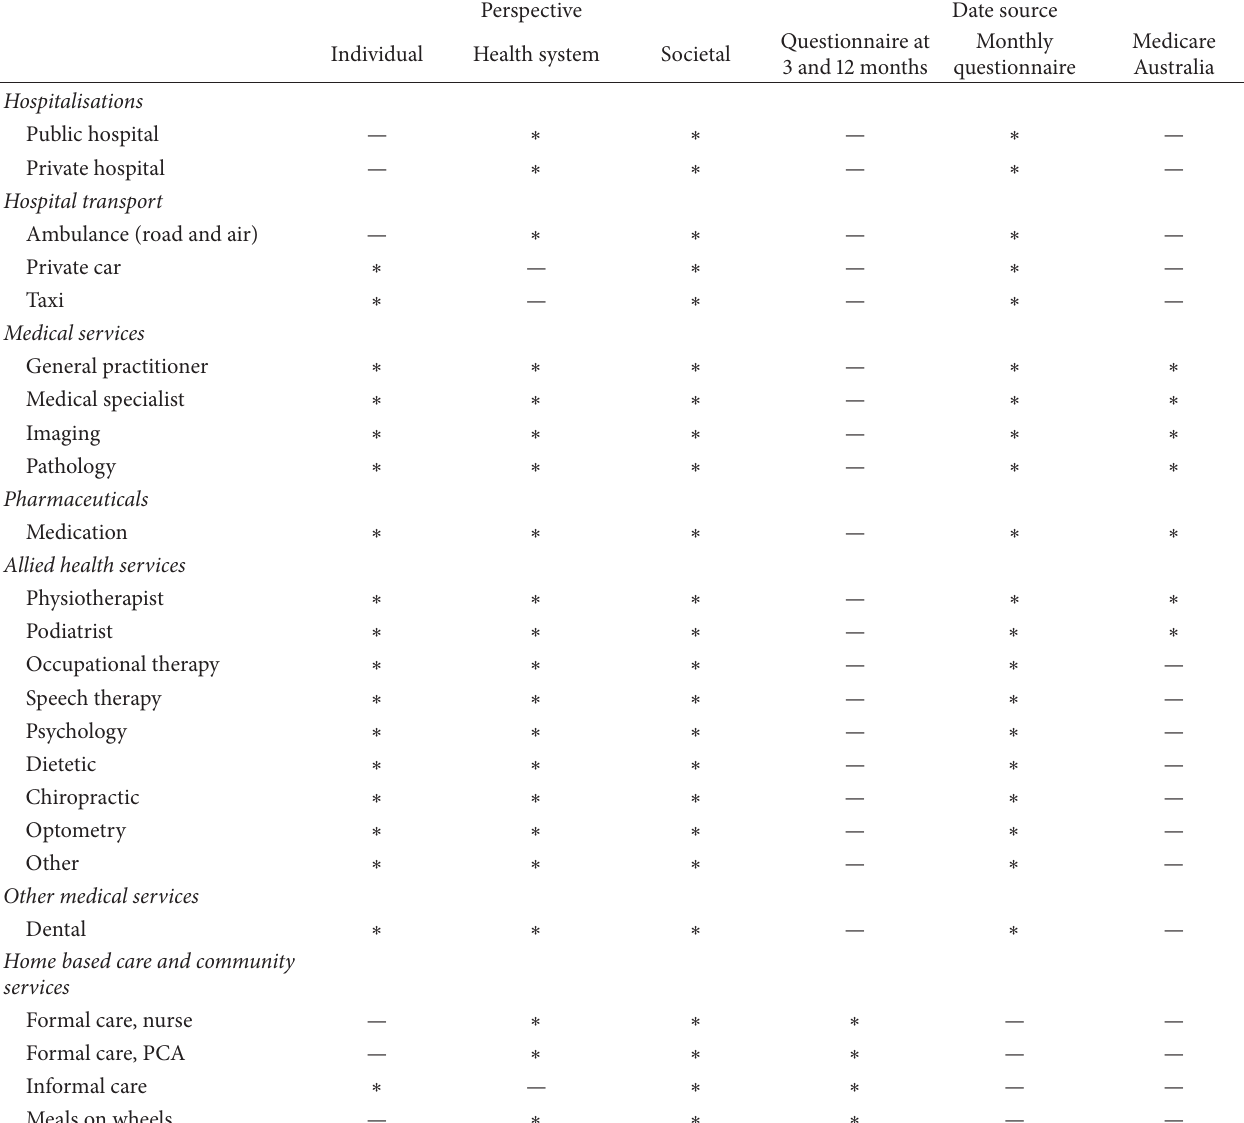
Table 1: Economic analysis perspectives and data collection